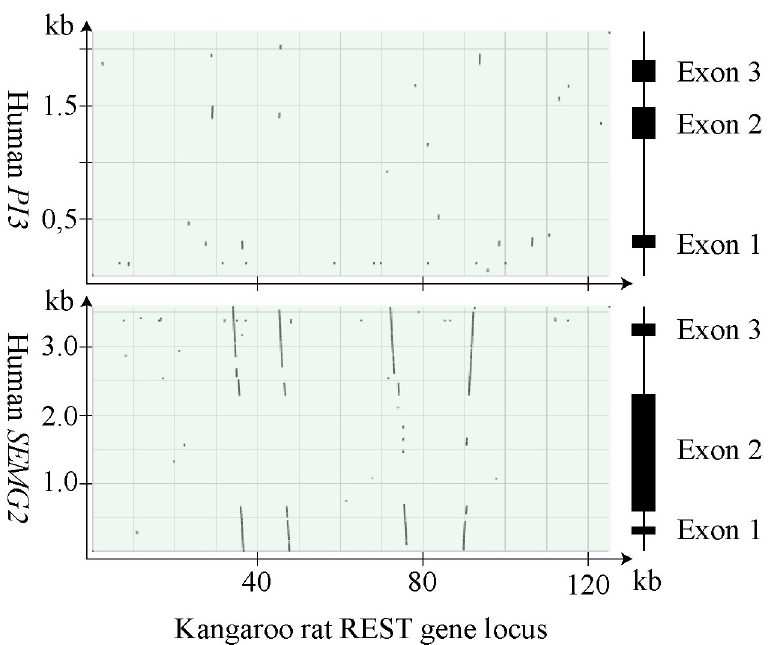
Fig 10. Homology with human SEMG2 at the REST gene locus in the kangaroo rat. The Kangaroo rat’s REST gene locus was searched for DNA sequences showing homology with human SEMG2 and PI3 using BLAST. The result displayed as dotplots are shown with illustrations of the human genes to the